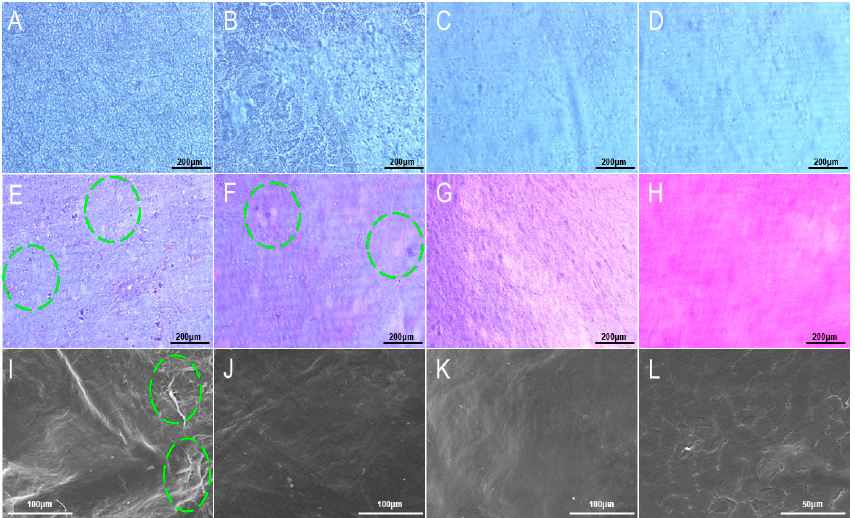
Figure 2. Bright field, HE staining and SEM images of HAAM by different methods. ( A ) Low concentration method after 12 h (×200); ( B ) High concentration method after 12 h (×200); ( C ) Low concentration method complete after 36 h (×200); ( D ) High concentration method complete after 24 h (×200); ( E ) Low concentration TritonX-100 method (×200); ( F ) High concentration TritonX-100 method (×200); ( G ) Hypertonic saline method (×200); ( H ) NaOH scrape method (×200); ( I ) Low concentration TritonX-100 method (×800); ( J ) High concentration TritonX-100 method (×800); ( K ) Hypertonic saline method (×2000); ( L ) NaOH scrape method (×800). The circles represented broken peeling of the amniotic surface.